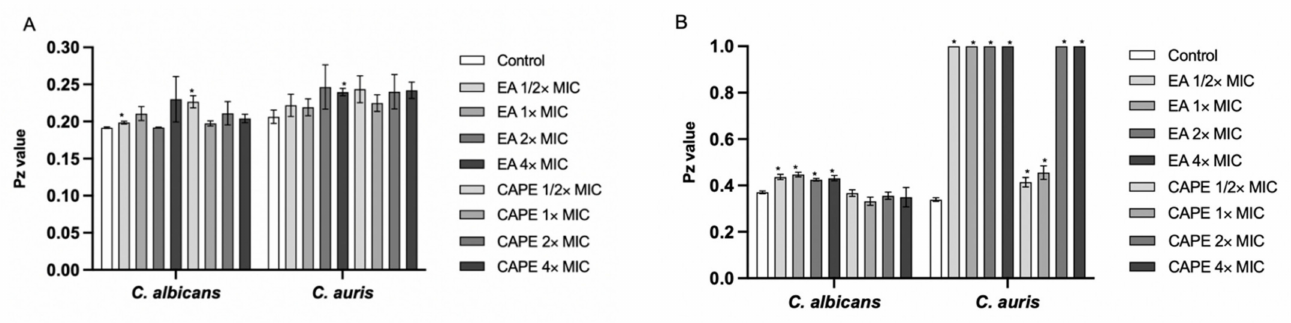
Figure 2. Effect of EA and CAPE on proteinase and phospholipase production. ( A ) Effect on proteinase secretion by C. auris CAU-04 and C. albicans SC5314 when exposed to different EA and CAPE concentrations. ( B ) Effect on phospholipase secretion by C. auris CAU-04 and C. albicans SC5314 when exposed to different concentrations of EA and CAPE. * p <